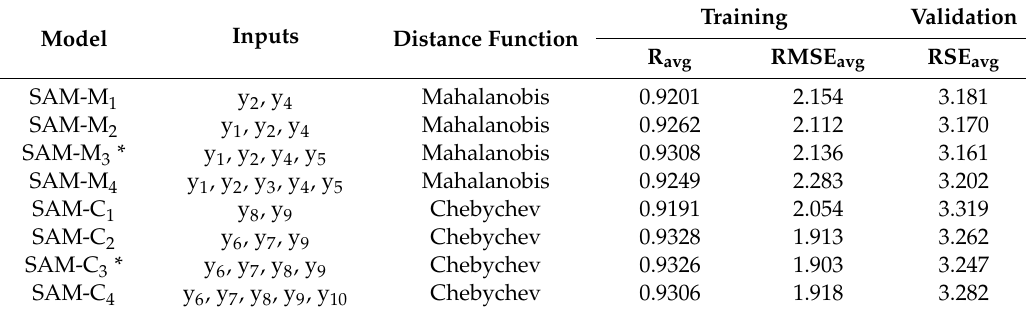
Table 3. Select kNN-based stacking ensemble models using single-type distance functions.